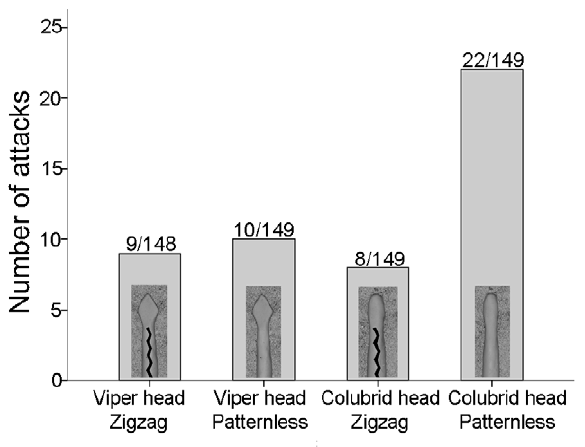
Figure 2. The number of attacks on snake replicas. The observed number of raptor attacks on different types of snake replicas. Numbers at the top of each bar represent the total number of observed raptor attacks on each type of snake replica in relation to the total number of replicas of that type used in the experiment.